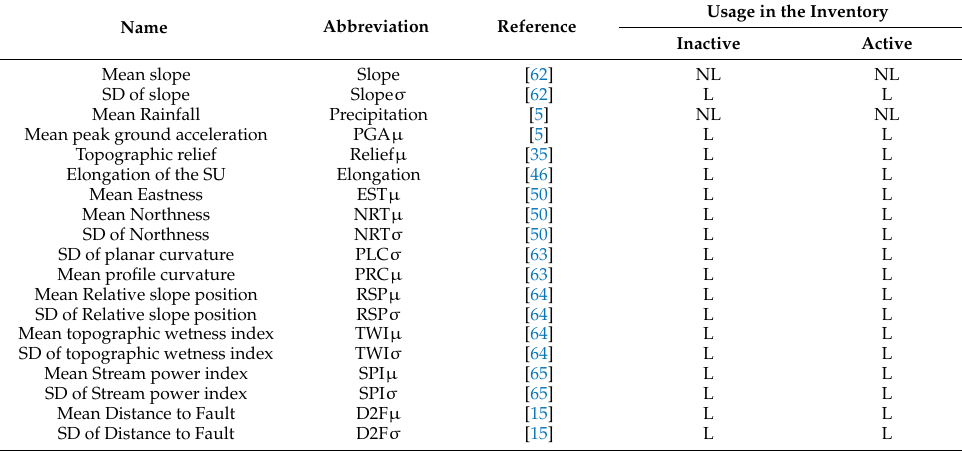
Table 1. List of covariates. L and NL indicate that the linear and nonlinear effects were investigated, respectively. SD stands for standard deviation. All values are calculated within each